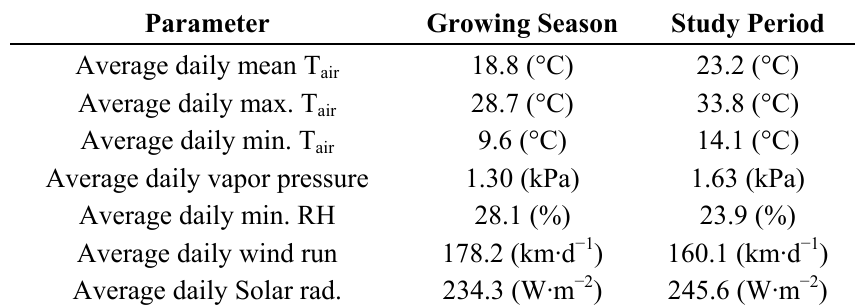
Table 2. Key weather parameters during the growing season and the study